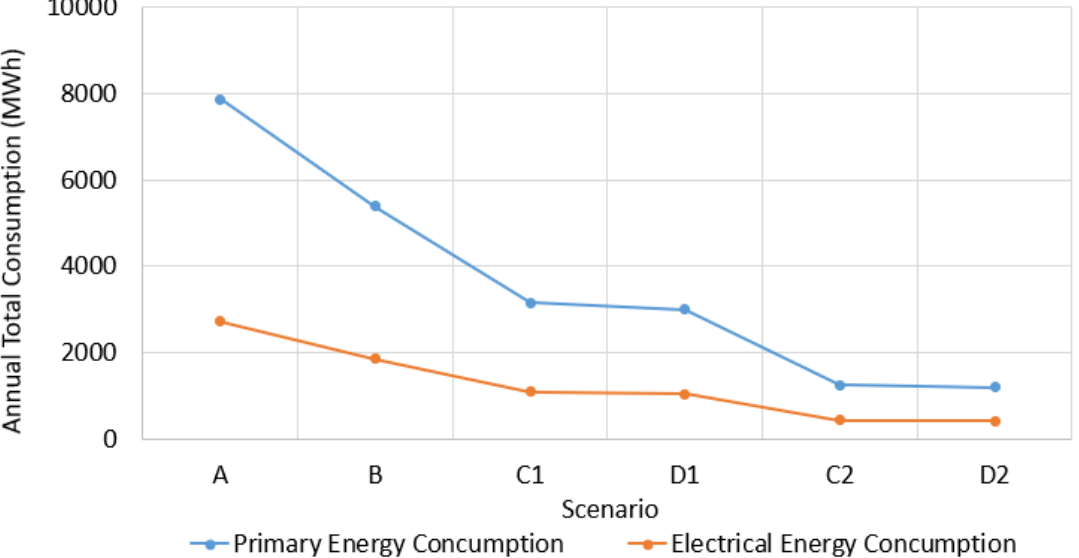
Figure 7. Total annual electrical and primary energy consumption for the examined scenarios.